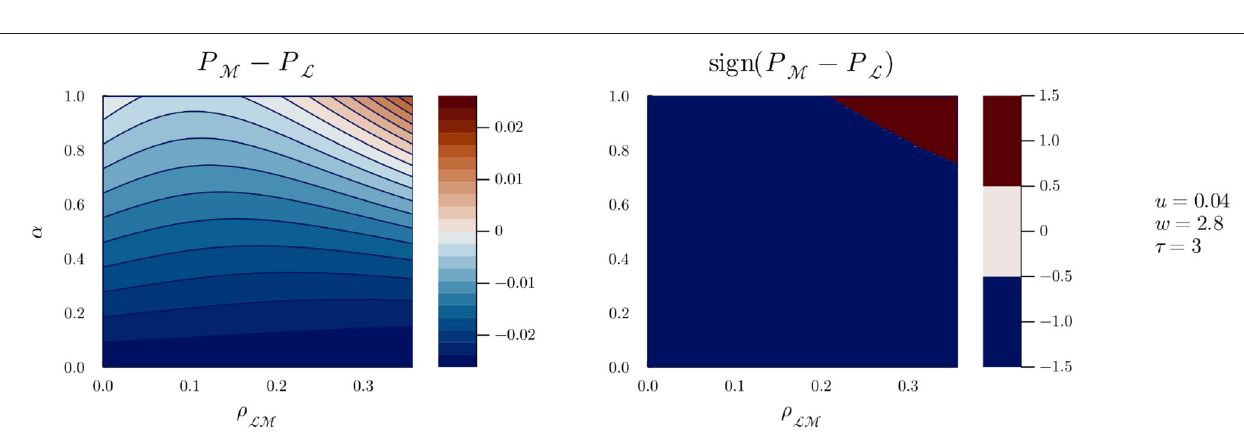
FIGURE 5 | g ( α , ρ LM ) for u = 0.04, w = 2.8, and τ = 3.